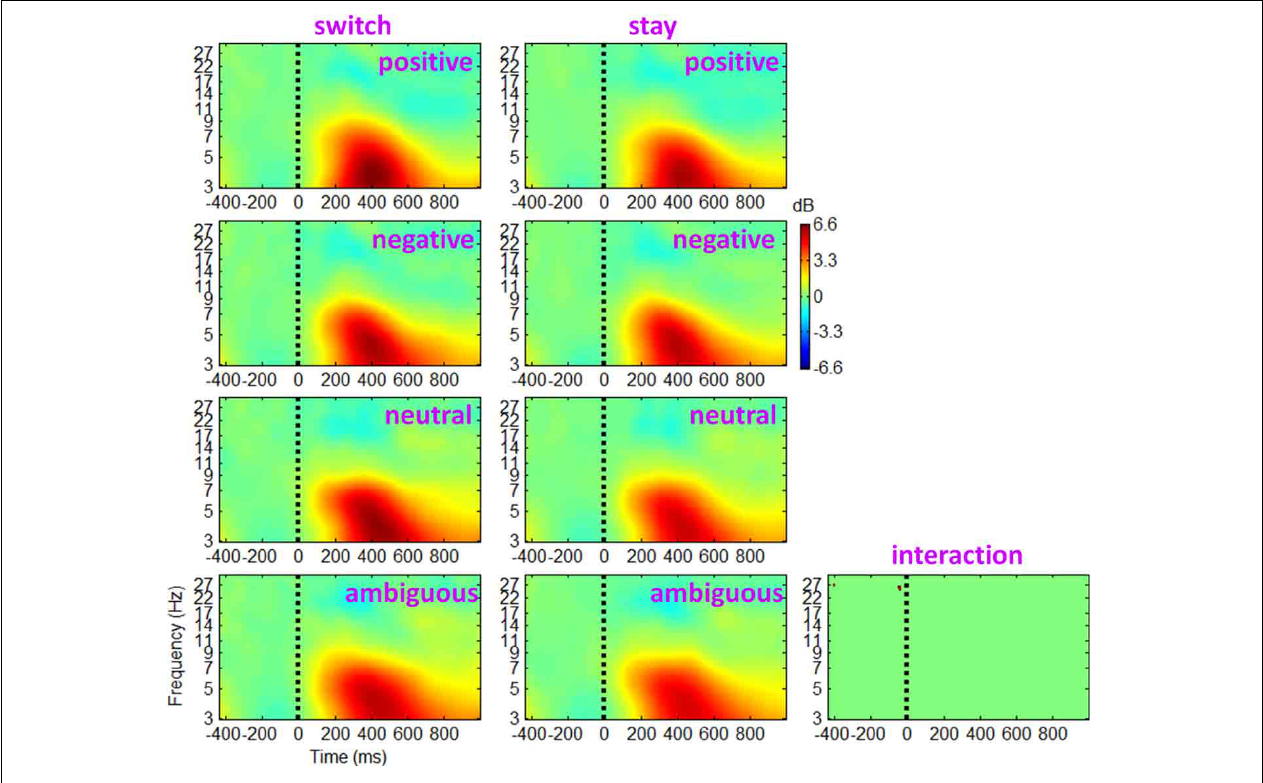
FIGURE 5 | Grand-mean ERSPs of the interaction effect of outcome valence by subsequent strategy based on channel EEG data. Results obtained from the electrode site Cz. Colored ERSP images were produced